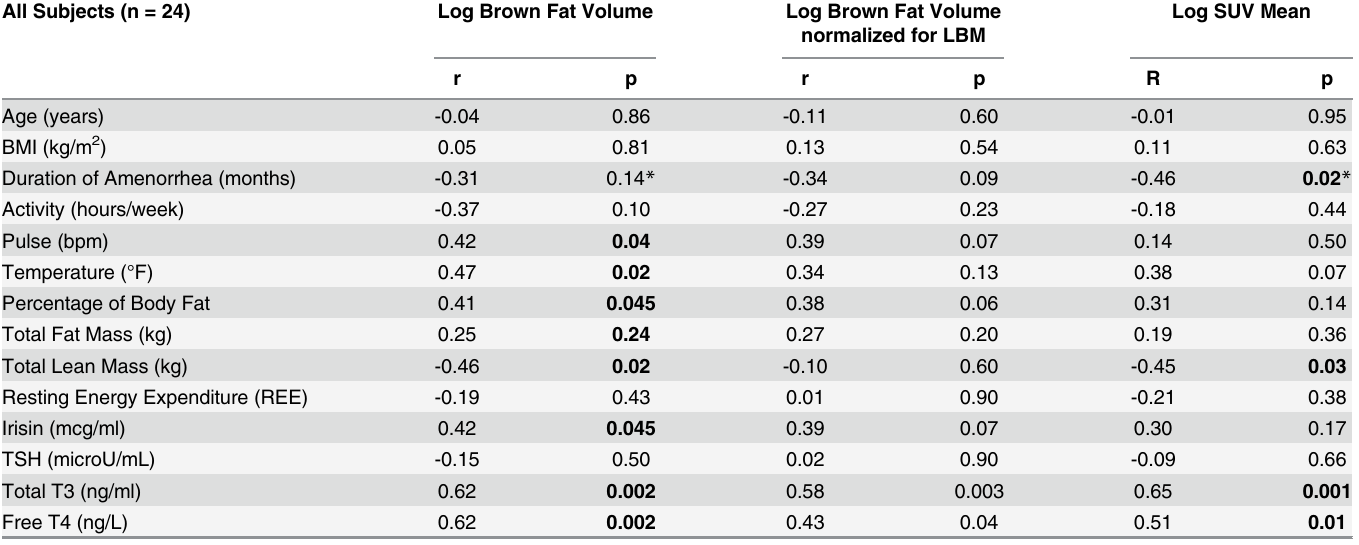
Table 2. Associations of Brown Fat with Clinical and Biochemical